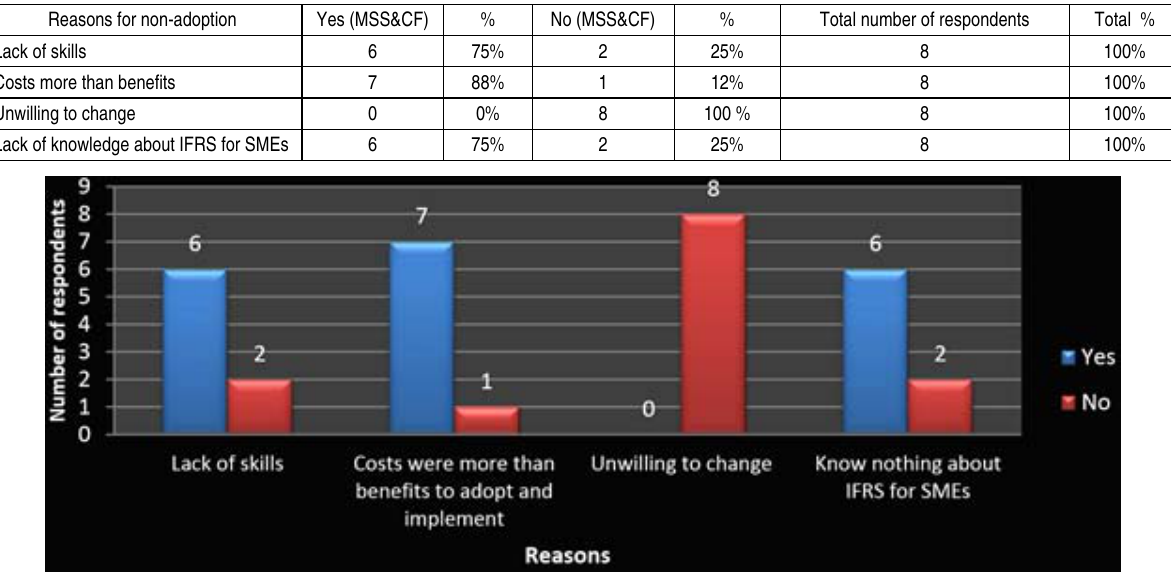
Fig. 7. Reasons for not adopting IFRS for